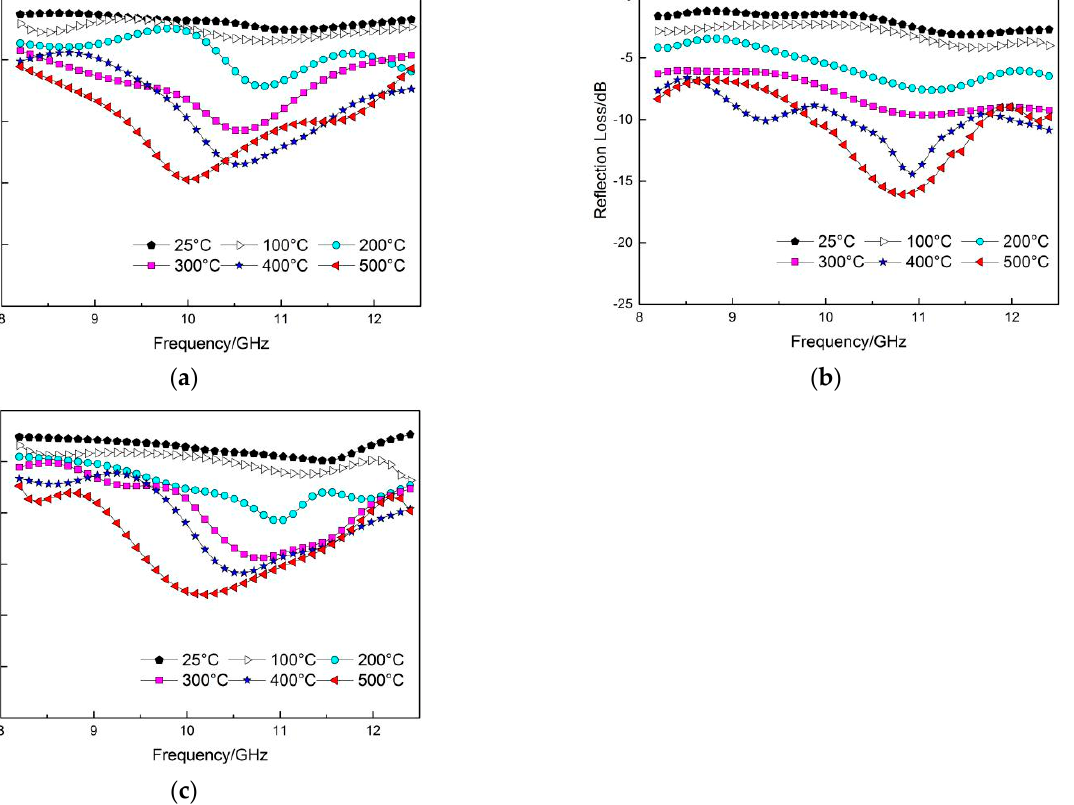
Figure 7. Reflection loss of the Al 2 O 3 -MoSi 2 -Cu composite coatings: ( a ) d = 1.3; ( b ) d = 1.5; ( c ) d = 1.7.